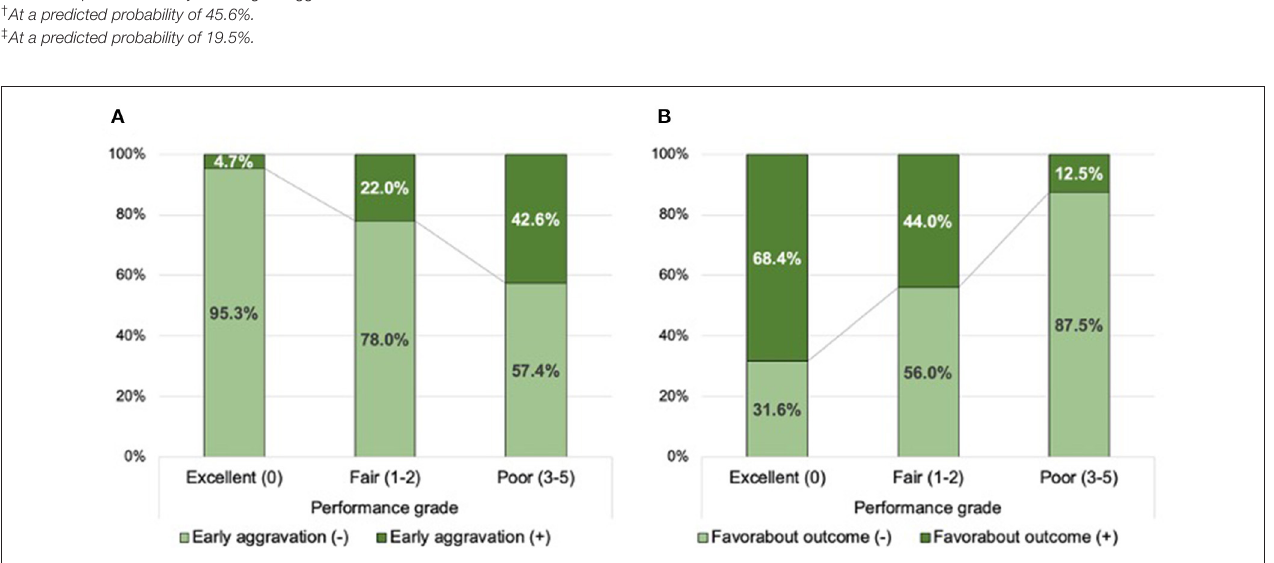
FIGURE 1 | Distribution of the successful recanalization score according to early neurological aggravation (A) and favorable outcomes (B) in the training